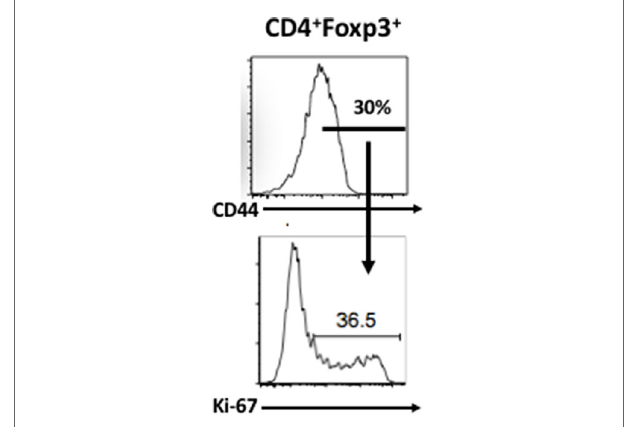
FigUre 1 | T regulatory Treg cells represent one of the most active cycling lymphocyte populations in vivo . After gating on Foxp3 + T cells, we then gated on the activated/effector/memory subset as define by high levels of CD44 expression. The CD44 hi population was then stained for Ki-67 expression. Ki-67 positivity reflects cell division over the previous 48-h